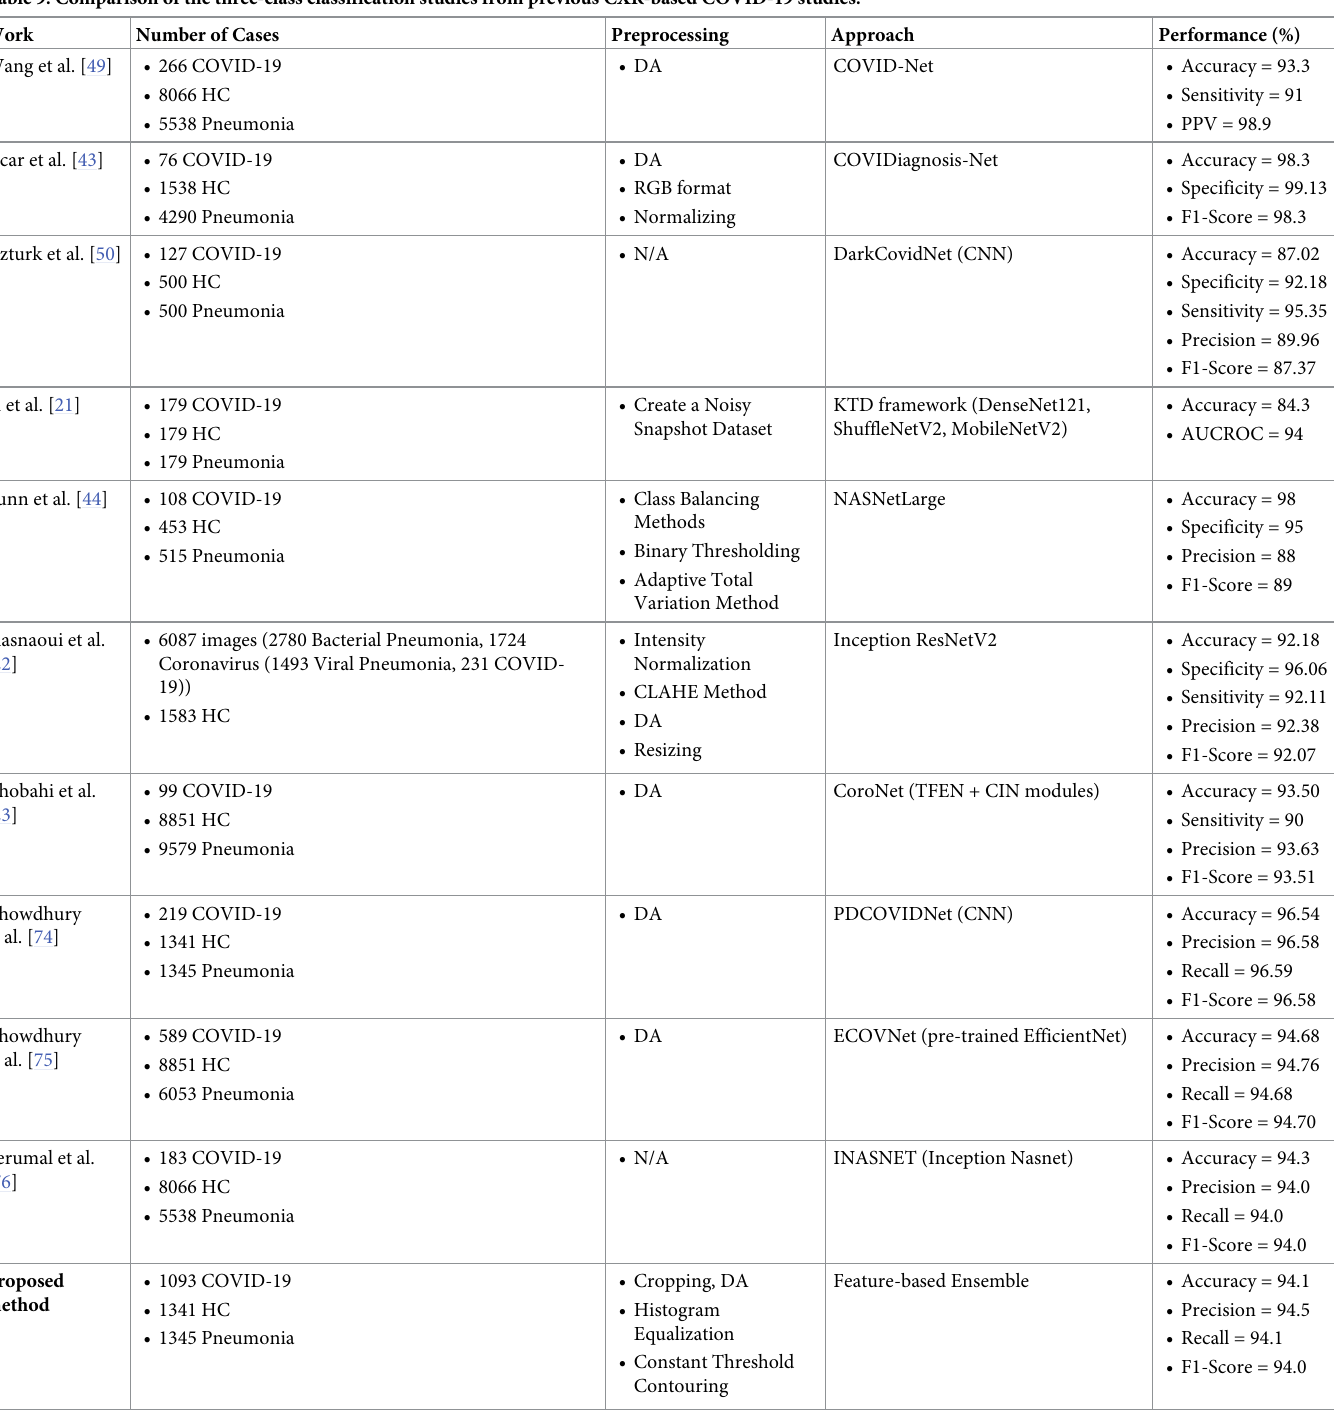
Table 9. Comparison of the three-class classification studies from previous CXR-based COVID-19